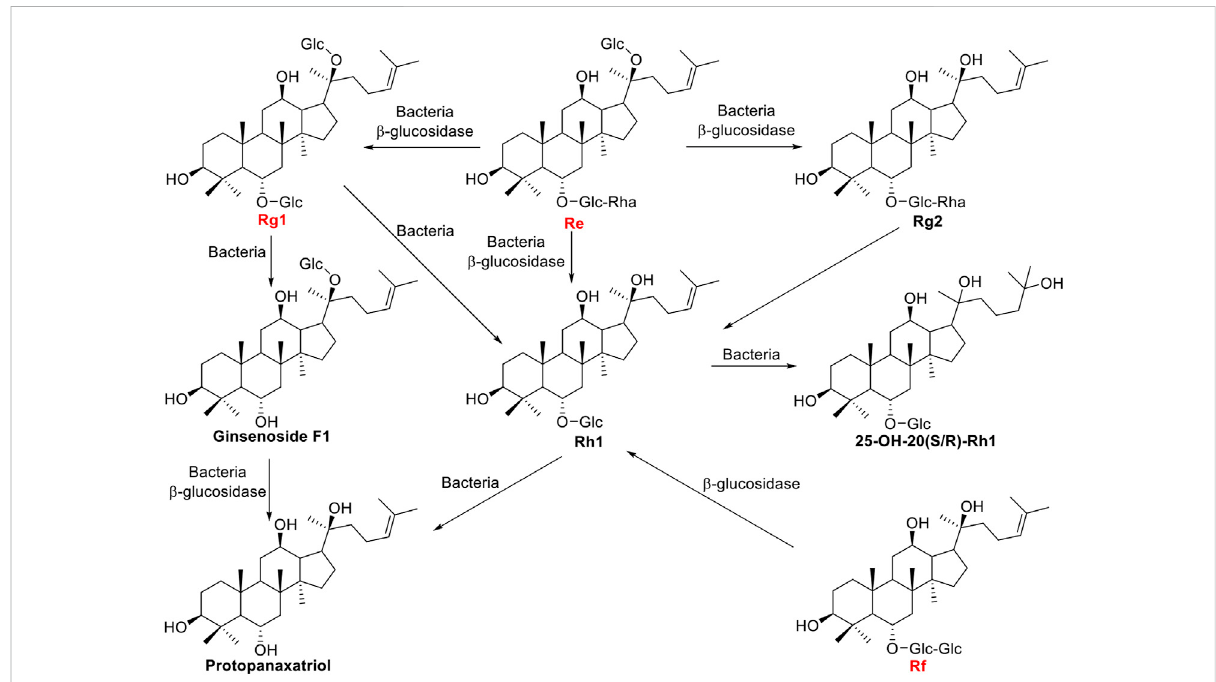
FIGURE 4 Schematic illustration of biotransformation of major PPT-type ginsenosides Re, Rf, and Rg1 into minor